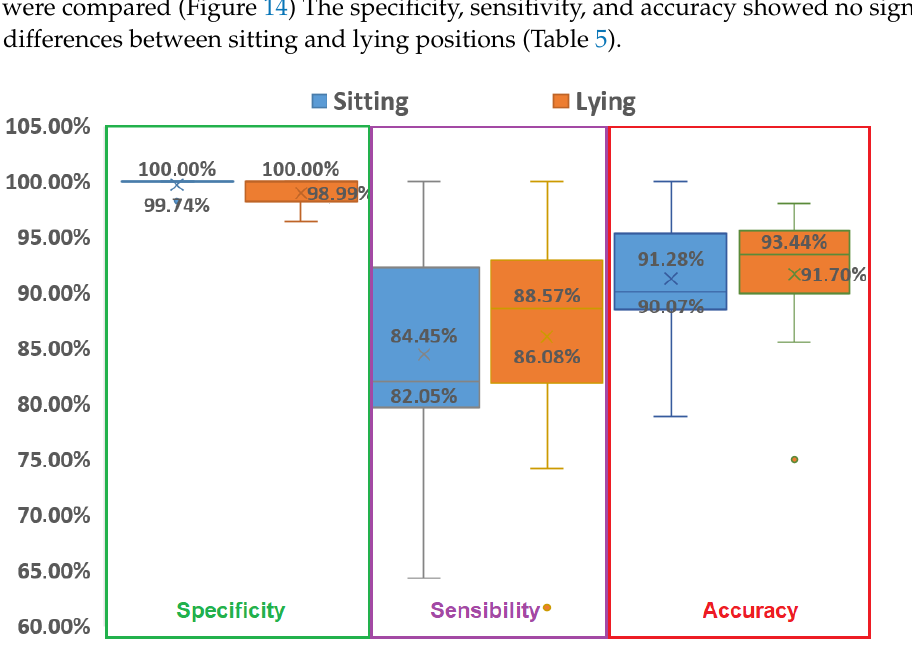
Figure 14. Box plot (like box plot of Figure 12) for specificity (green rectangle), sensitivity (purple rectangle), and accuracy (red rectangle) in sitting (orange boxes) and lying (blue boxes) positions. Table 5. Median values comparing for specificity, sensitivity, and accuracy—sitting vs.